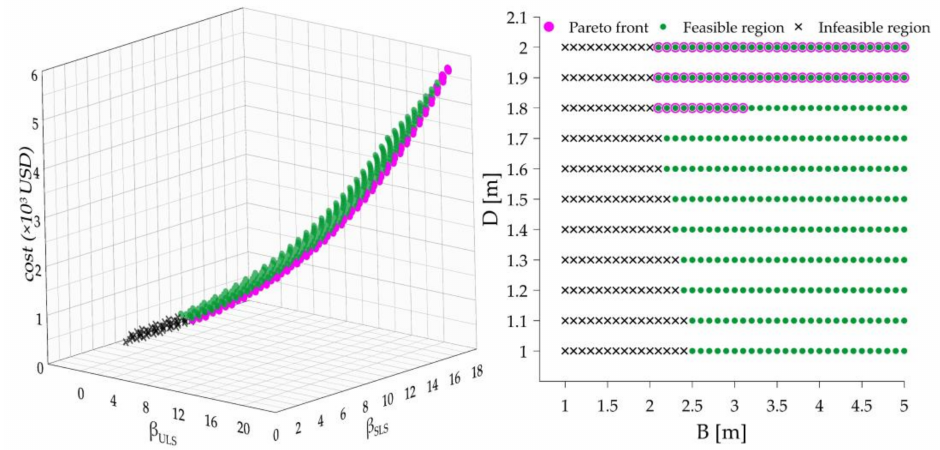
Figure 10. The Pareto front, along with the dominated and infeasible designs in objective space ( left ) and decision space ( right ).